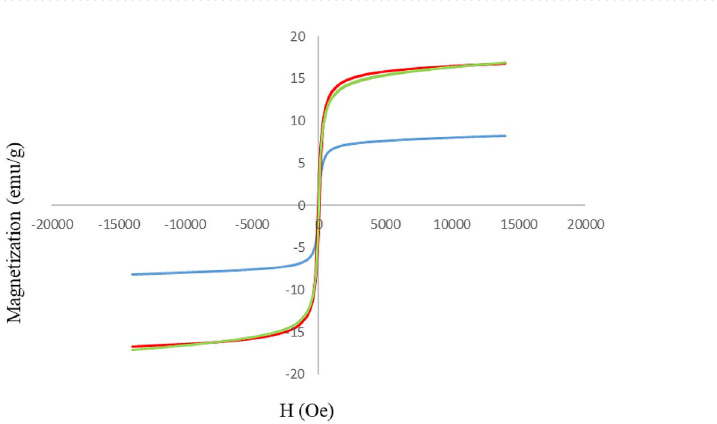
Figure 6. Elemental mapping of SSE@GO-CuFe 2 O 4 nanocomposite.